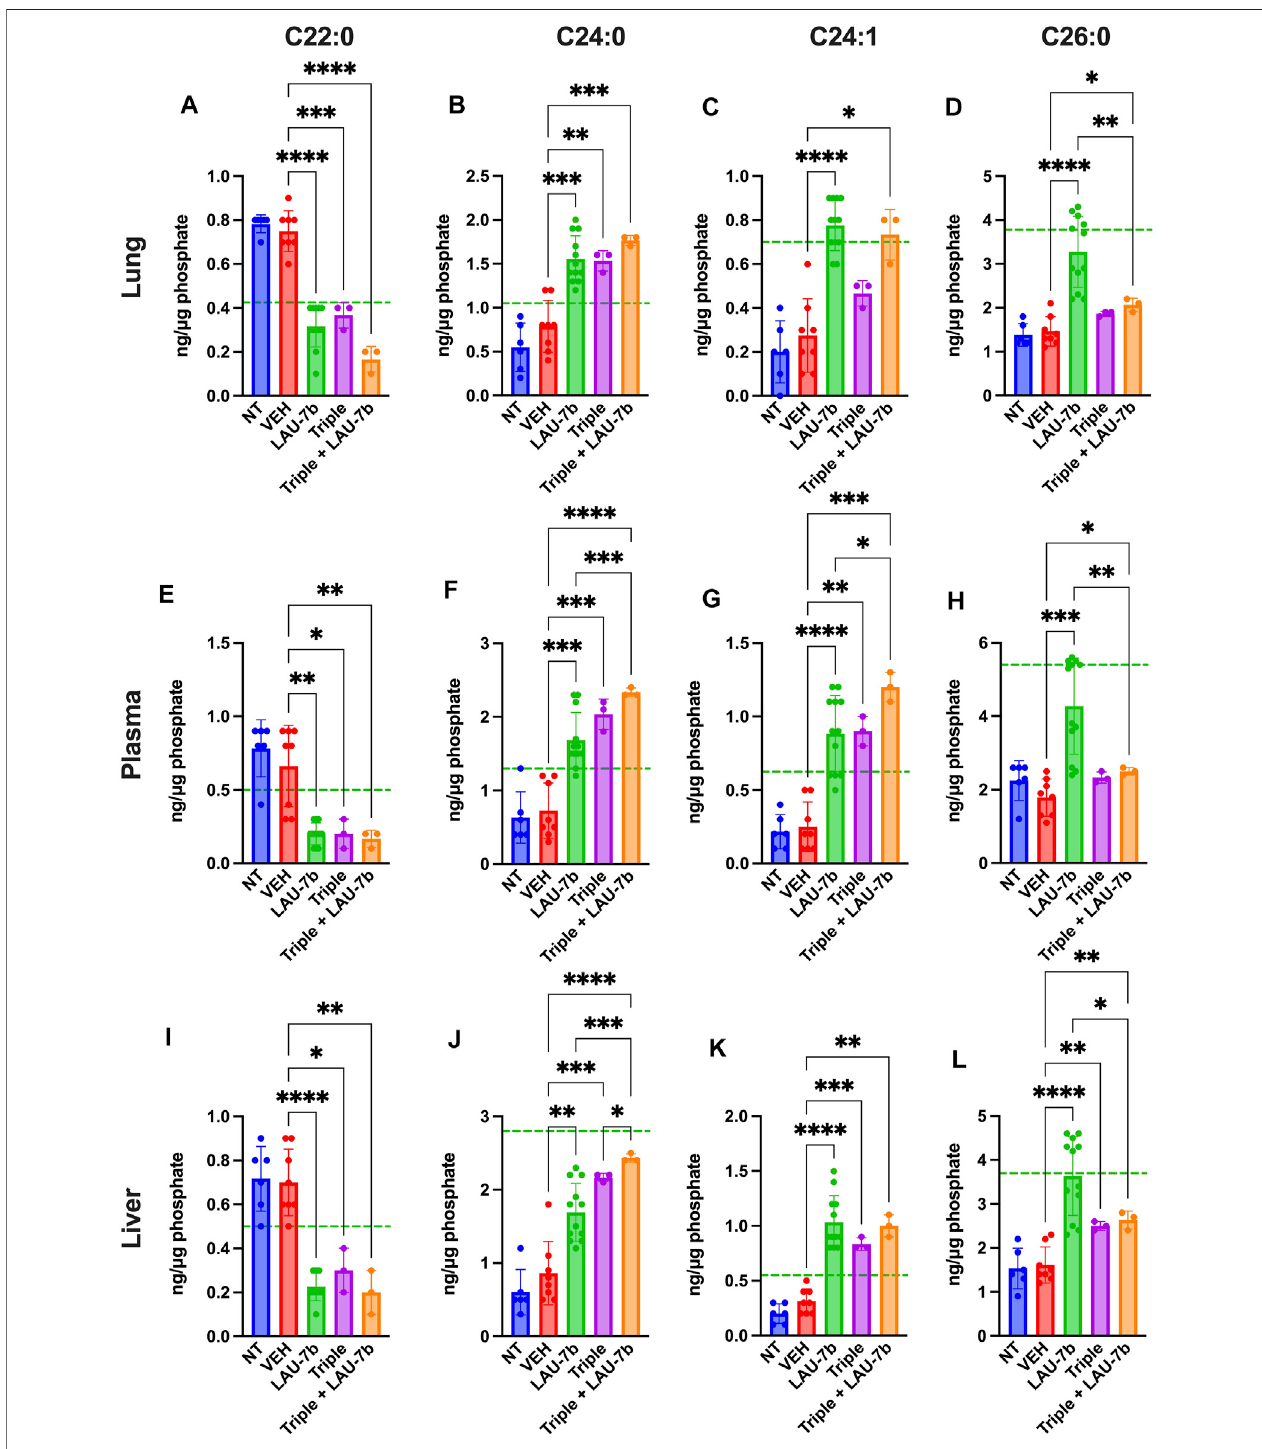
FIGURE 7 | Combination of Triple therapy and LAU-7b exhibits stronger effects in correcting levels of very long-chain ceramides (VLCCs) than Triple therapy treatment alone in the lungs, plasma, and liver of F508del/F508del (DD) mice. Mass spectrometry analysis of mouse lungs (A – D) , plasma (E – H) and liver (I – L) . Upon treatment of LAU-7b and Triple therapy on their own, VLCC C22:0 shows signi fi cant decrease while C24:0 and C24:1 show a signi fi cant increase when compared to vehicle treated DD mice in all samples. Moreover, levels are corrected towards mean levels seen in WT mice (dotted green line). Meanwhile, only LAU-7b signi fi cantlyincreaseC26:0levels.CombinationtreatmentofLAU-7bandTripletherapyshowstrongereffectsforVLCCsC22:0,C24:0andC24:1thanwithTriplealone. However, VLCC C26:0 is somewhat increased by Triple and combination therapy but is not as strong as with LAU-7b alone ( n = 6, 8, 12, 3, 3, respectively, for DD-NT, DD-VEH, DD-LAU-7b, DD-Triple, DD-Triple + LAU-7b). Brown-Forsythe and Welch One-Way ANOVA with Dunnett T3 correction, where * p < 0.05, ** p < 0.01, *** p < 0.001, **** p < 0.0001.